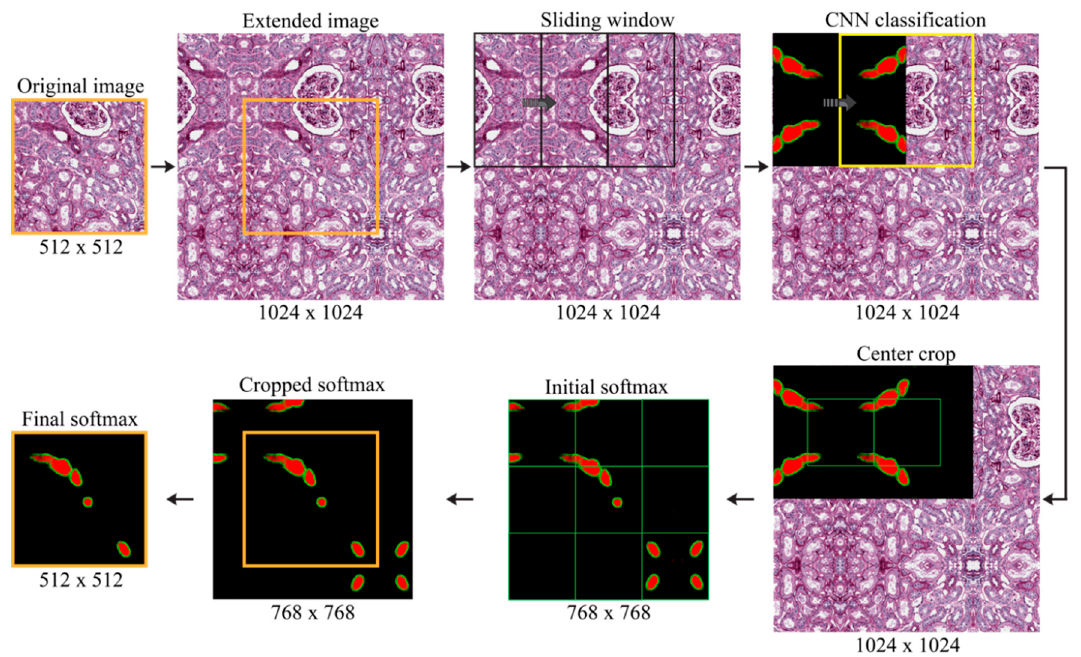
Figure A1. Procedure for the creation of the final CNN softmax. The original image is mirrored around the boundaries to obtain the extended image. Then, a sliding window approach is employed to classify each patch, and only the center of each prediction is kept to build the final softmax.